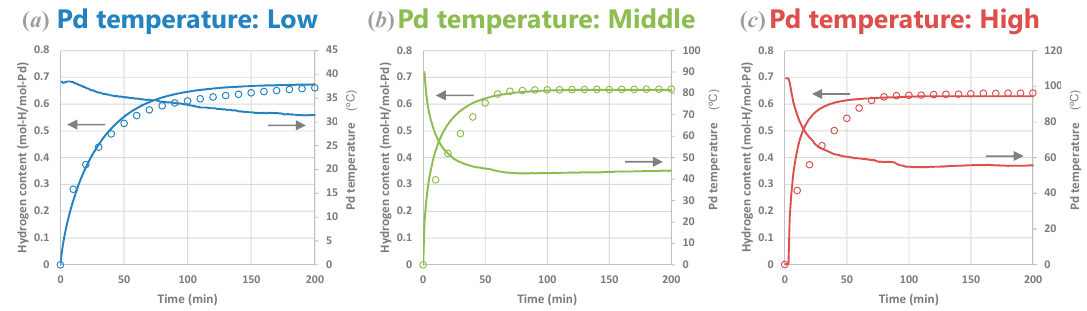
Figure 12. Experimental results (blank circles) and numerical fitting (solid lines) of time evolution of hydrogen content in Pd at different temperatures ( a : low, b : middle, and c : high temperature ranges). The fitting parameters were k sb0 = 1.4 × 10 13 s − 1 and k bs0 = 6.2 × 10 12 s − 1 for all the calculations.